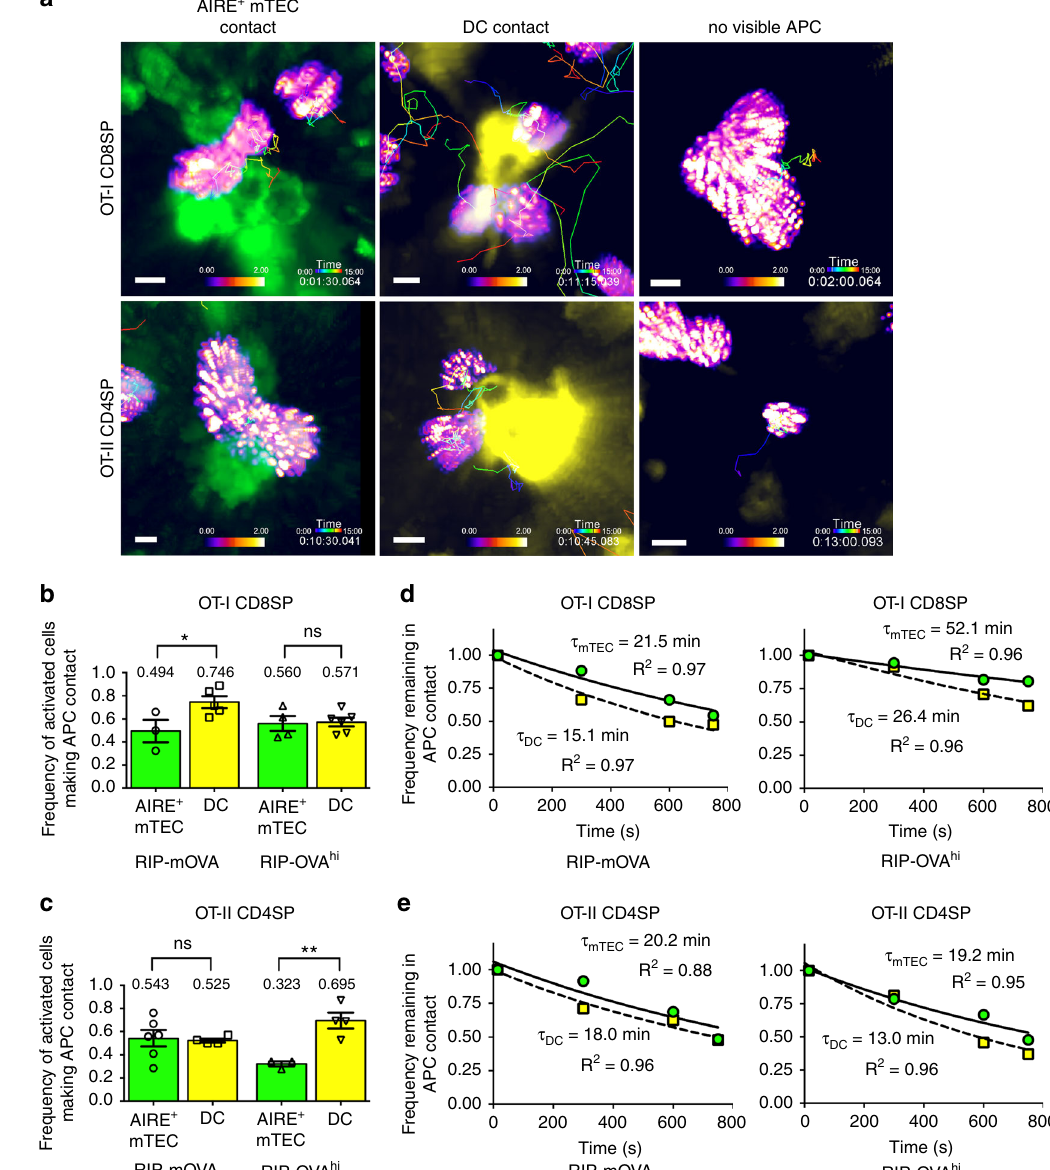
Fig. 4 AIRE + mTECs and DCs contribute differentially to activation of OT-I and OT-II SPs undergoing negative selection in RIP-mOVA versus RIP-OVA hi slices. a Representative 2PM images of activated OT-I CD8SP and OT-II CD4SP thymocytes contacting AIRE + mTECs, DCs, or no visible APC. Thymocyte track time is color-encoded. Scale bar is 5 µ m. b , c Frequency of activated b OT-I CD8SPs and c OT-II CD4SPs interacting with AIRE + mTECs or DCs on thymic slices expressing RIP-mOVA or RIP-OVA hi TRAs, from Adig (green) or CD11c-EYFP (yellow) reporter mice. Data points represent the average of all cells in an experiment, and bars show mean ± SEM. Data from 3 to 6 experiments per condition, number of cells: RIP-mOVA ( N OT-I = 371, N OT-II = 265), RIP-OVA hi ( N OT-I = 301, N OT-II = 283). Analyzed by unpaired t tests, p -values: * < 0.05, ** < 0.01. ns not signi fi cant. d , e The frequencies of activated d OT-I CD8SPs and e OT-II CD4SPs that remain in contact with their activating AIRE + mTEC (green) or DC (yellow) for the 15-min imaging duration on RIP-mOVA or RIP-OVA hi thymic slices were fi t to a one-phase exponential decay. Nonlinear fi t shown for interaction with mTEC (solid line) and DC (dashed line), mean lifetime τ , and goodness of fi t R 2 as indicated. Data are compiled from 3 to 6 experiments per condition, number of cells: RIP-mOVA ( N OT-I = 148, N OT-II = 104), RIP-OVA hi ( N OT-I = 146, N OT-II = 104). Source data are provided as a Source Data fi le. See also Supplementary Figs. 5,